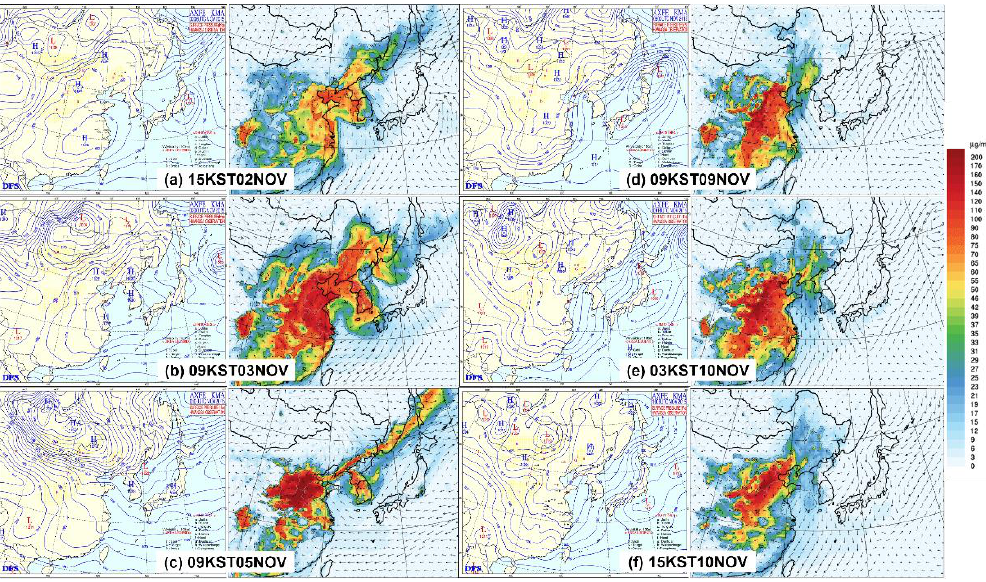
Figure 4. Weather charts and simulated PM 2.5 concentrations from CMAQ in northeast Asia for Case1 ( a – c ) and Case 2 ( d – f ), November, 2015 (( a ) 2 November 15:00 KST; ( b ) 3 November 09:00 KST; ( c ) 5 November 09:00 KST; ( d ) 9 November 09:00 KST; ( e ) 10 November 03:00 KST; ( f ) 10 November 15:00 KST).